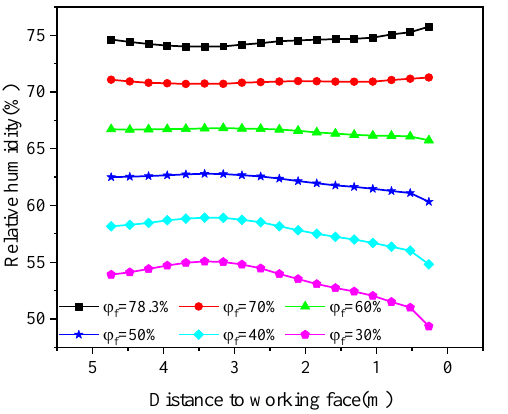
Figure 15. Relative humidity distribution of drift centerline under different supply air humidity.